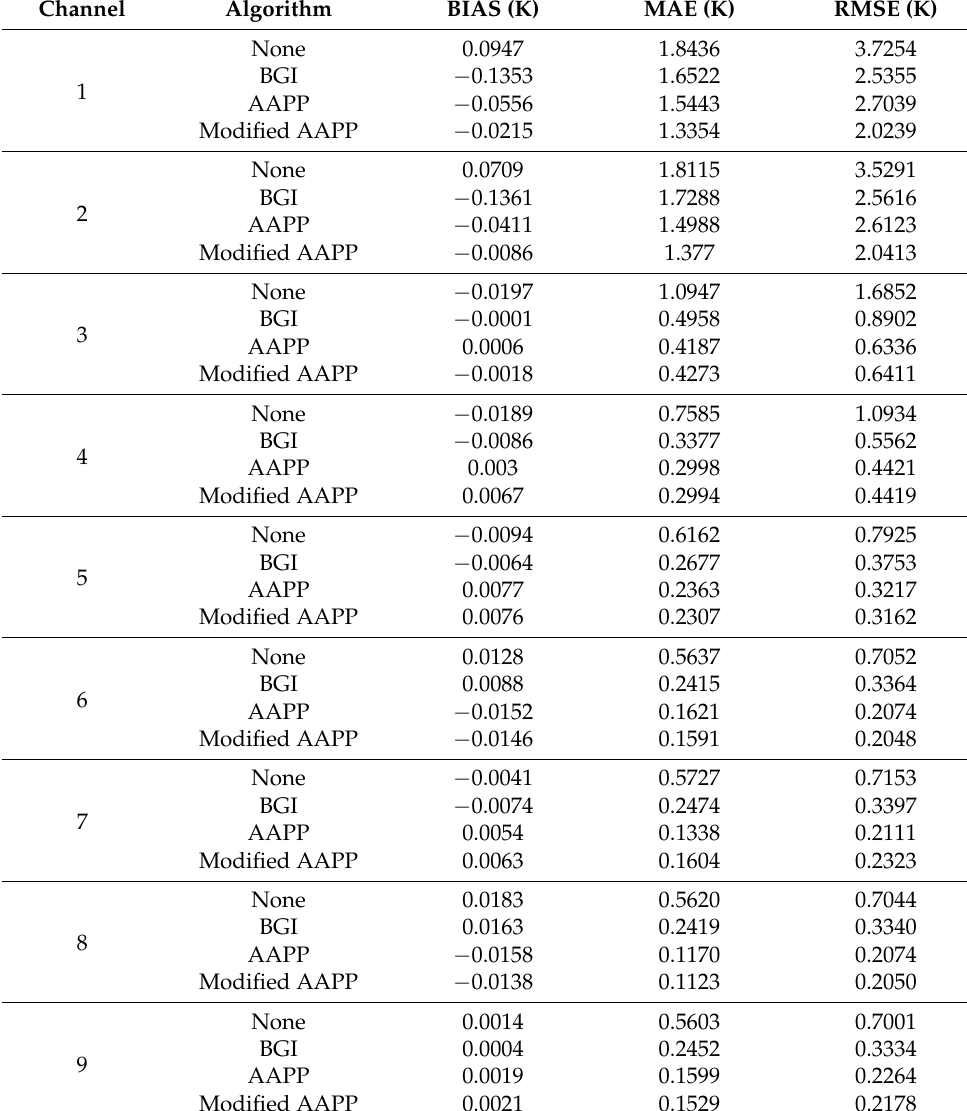
Table 2. BIAS, MAE, and RMAE errors between the resampled antenna brightness temperature and the true value of channels